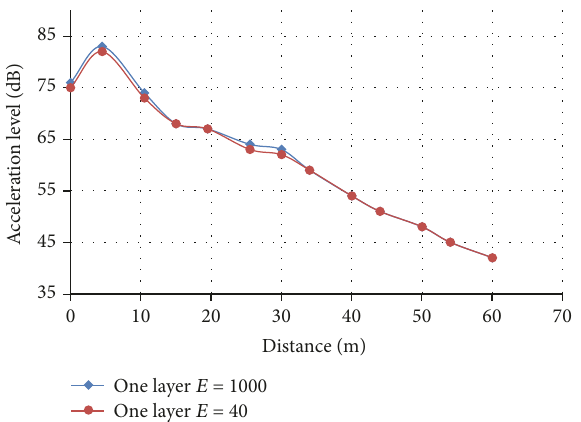
Figure 13: The comparison of acceleration level between case 1 and case 6 in Scheme 2 .